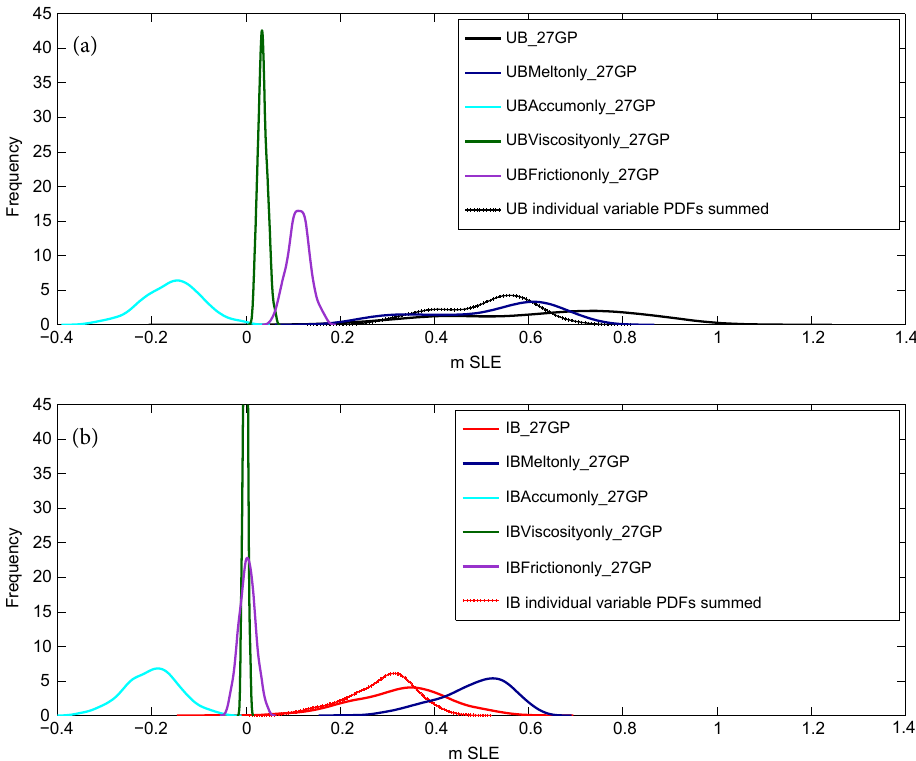
Figure 3. PDF of SLE from ensemble runs with 800 simulations using GP partitioning for sampling variables in combination and individ- ually. Both the (a) UB (solid black line) and (b) IB (solid red line) experiments are included. Variables ice shelf basal melt, accumulation, ice viscosity, and basal friction are sampled together randomly (UB_27GP, IB_27GP). Curves of other colors represent the sampling of each variable individually: ice shelf basal melt (UBMeltonly_27GP, IBMeltonly_27GP: dark blue), accumulation (UBAccumonly_27GP, IBAccu- monly_27GP: cyan), ice viscosity (UBViscosityonly_27GP, IBViscosityonly_27GP: dark green), and basal friction (UBFrictiononly_27GP, IBFrictiononly_27GP: purple). Hash-marked curves represent the sums of the individual variable curves, for (a) UB (black) and (b) IB (red). See Table 3 for statistics relating to each